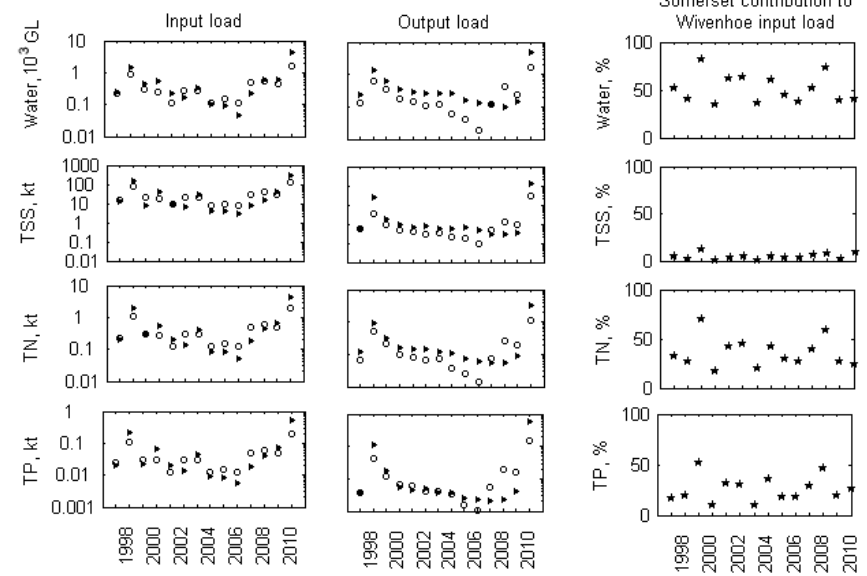
Figure 3. Annual input and output loads of water (10 3 GL), TSS and nutrients (kt) for the Somerset (o) and Wivenhoe ( (cid:73) ) reservoirs for water years 1997–2010, and the percentage contribution of Somerset to Wivenhoe input